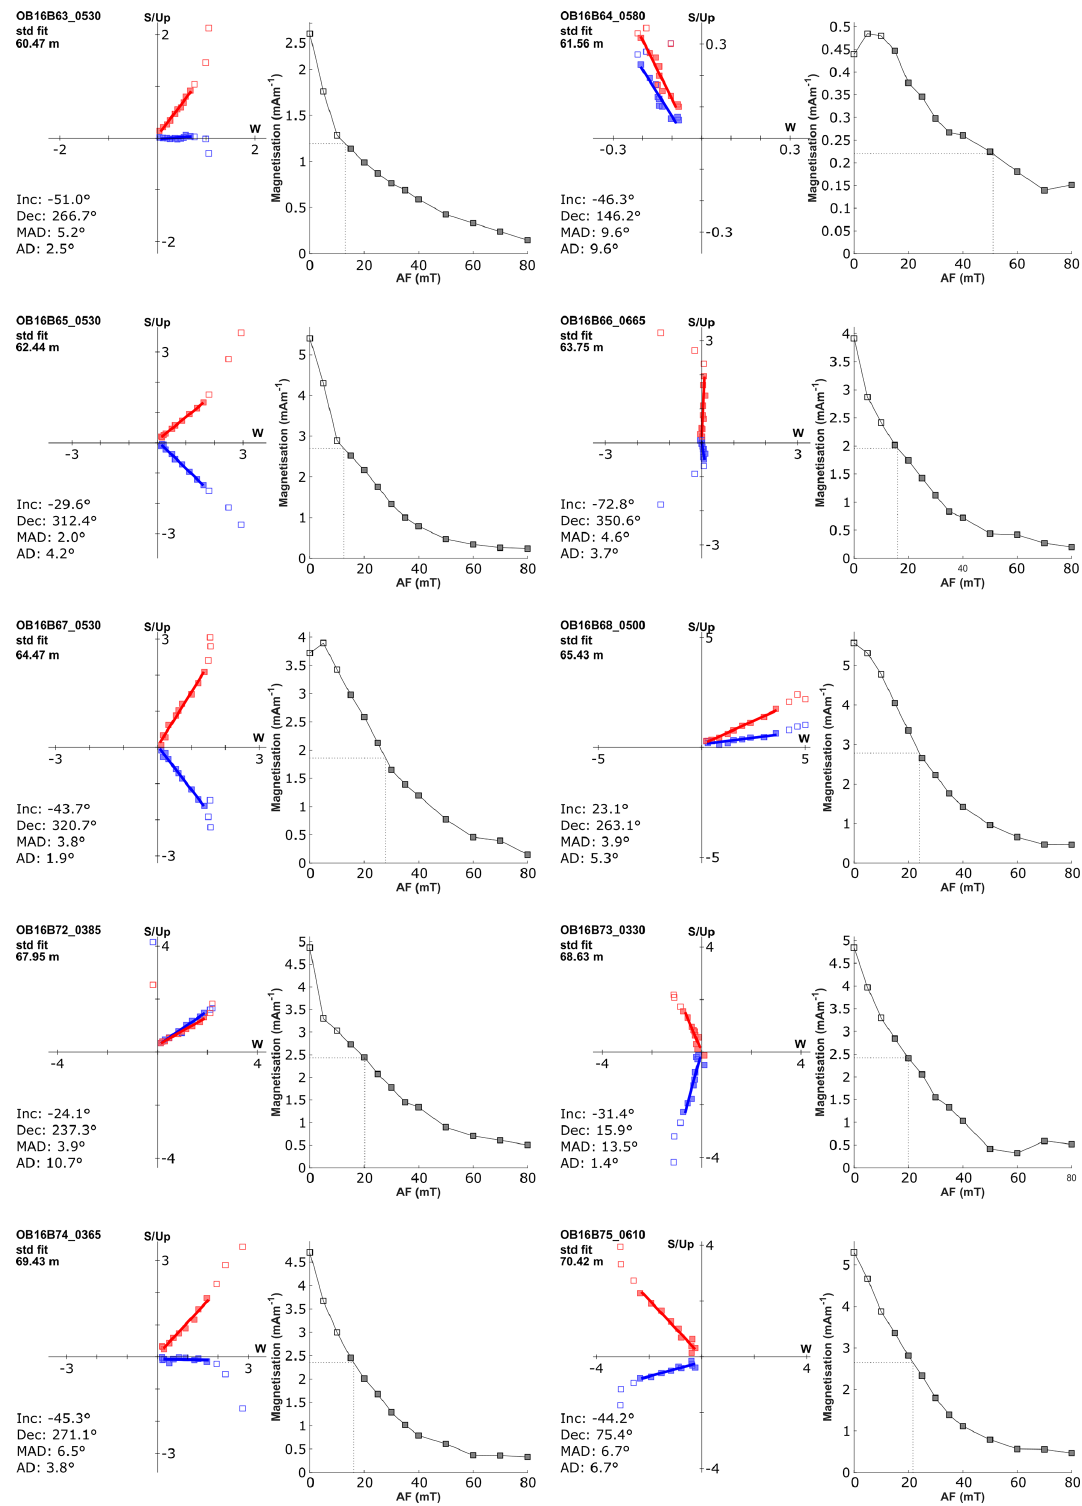
Figure C3. Orthogonal plots and intensity of magnetisation after stepwise demagnetisation of pilot samples OB16B63-75.